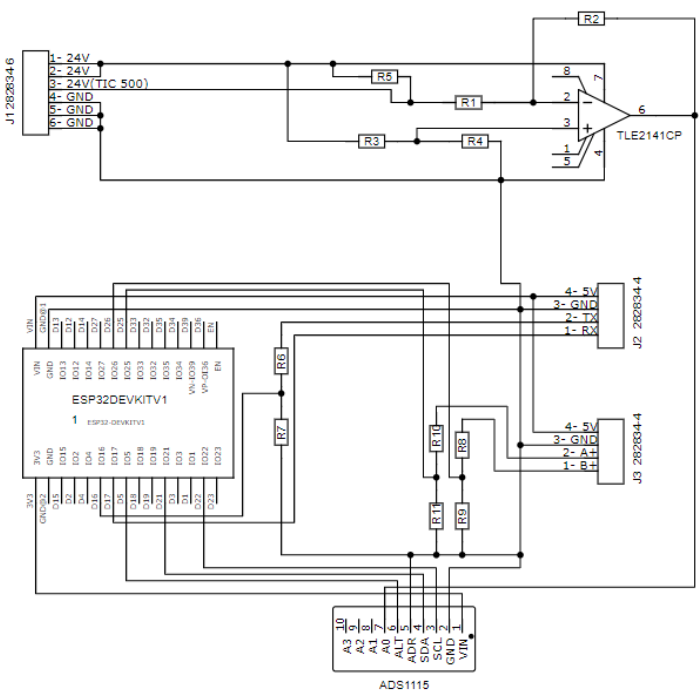
Figure 9. Connection diagram between devices of each axis.